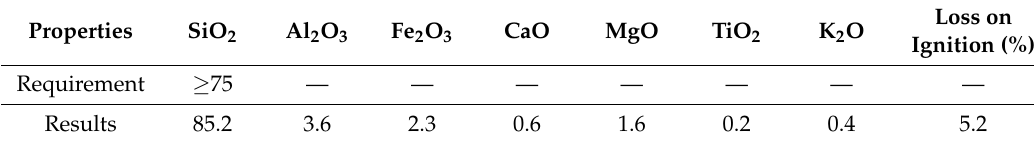
Table 3. The physical properties of diatomite.